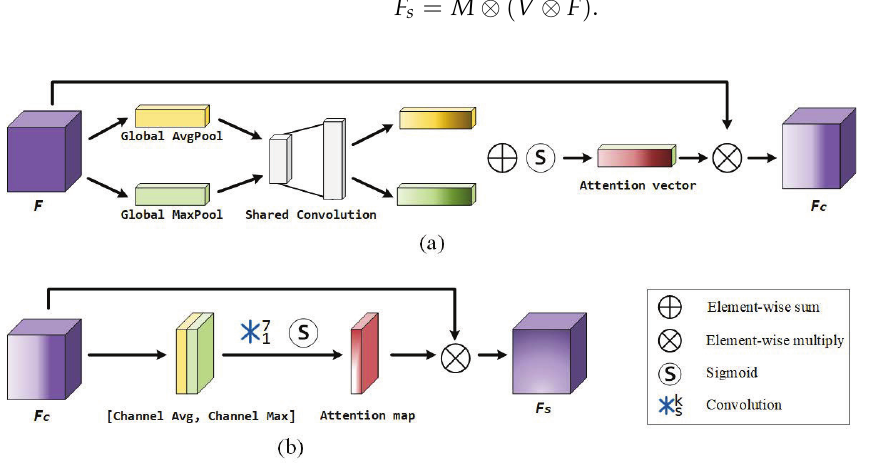
Figure 6. The channel attention mechanism and spatial attention mechanism. ( a ) and ( b ) respectively denote the channel attention module and spatial attention